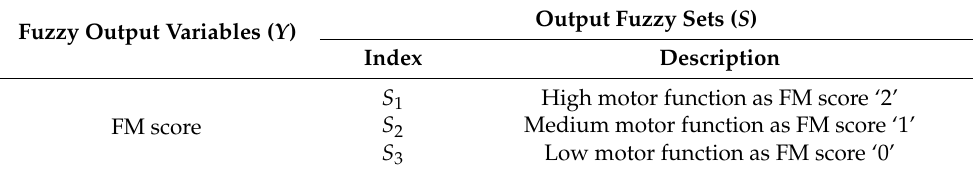
Table 3. Fuzzy output variables and their fuzzy